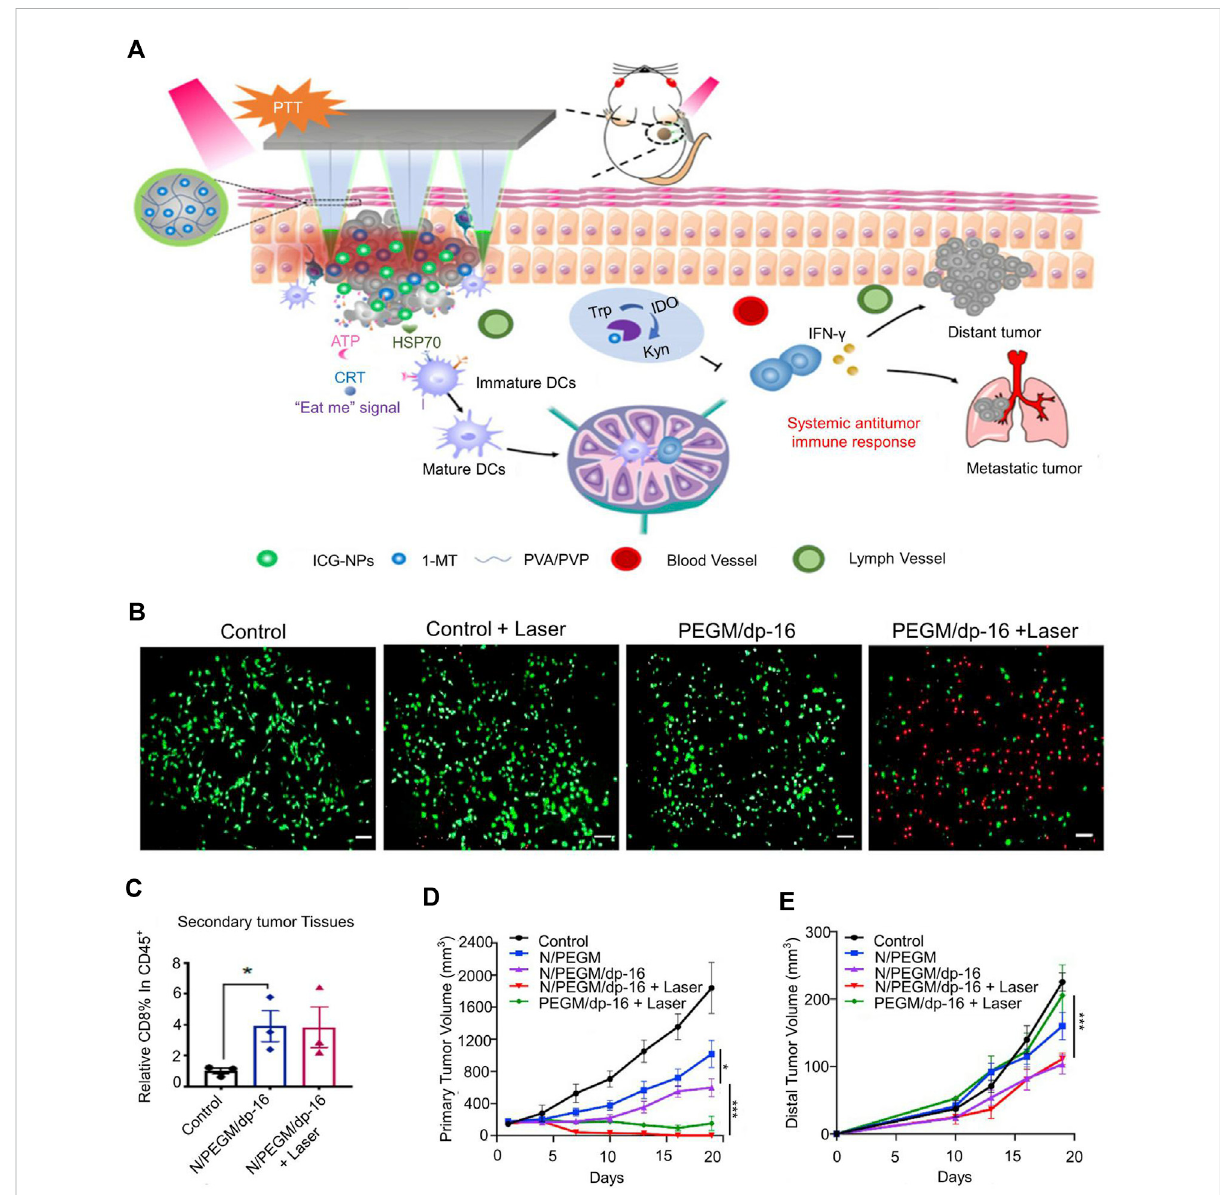
FIGURE 2 Tumorsize-dependentabscopaleffectofpolydopamine-coatedall-in-onenanoparticlesforimmunochemo-PTT. (A) Schematicillustrationof the mechanism of anti-tumor immunity. (B) The fl uorescence images of PANC02 cells co-stained with fl uorescein diacetate (FDA, green) and propidium iodide (PI,red) after various treatments. (C) Percentages of CD8 + T within the gated CD45 + population in primary tumors. (D) The tumor volume of primary tumor. (E) The tumor volume of distant tumor. Reproduced with permission from (Sun et al., 2020a; Chen et al.,